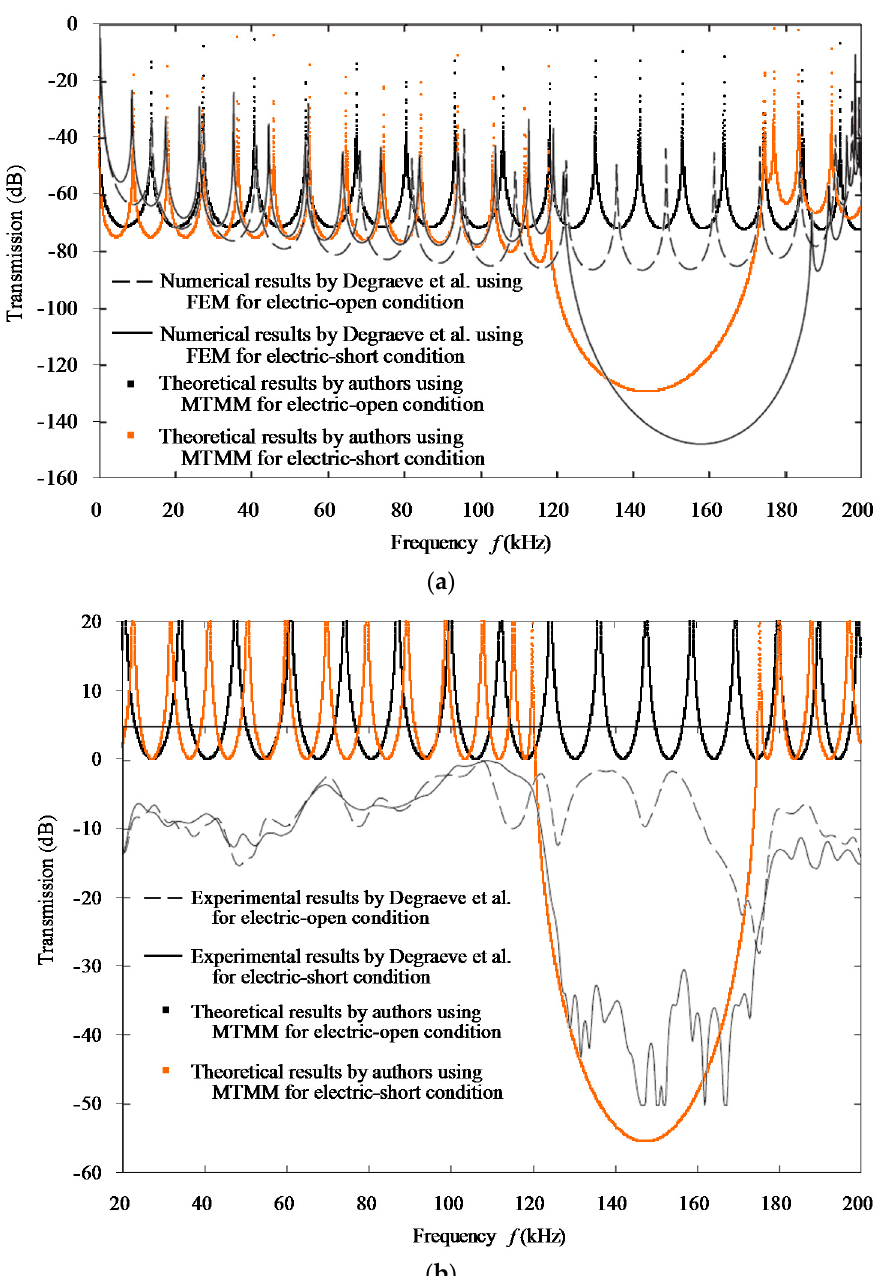
Figure 5. The transmission (in dB units) in a finite periodic PZT-5H piezoelectric rod covered by brass electrodes consisting of 14 unit cells with electric-open and electric-short boundaries from our MTMM and their comparison with the corresponding ones by Degraeve et al. [20]: ( a ) comparison with the numerical transmission; and ( b ) comparison with the experimental transmission.